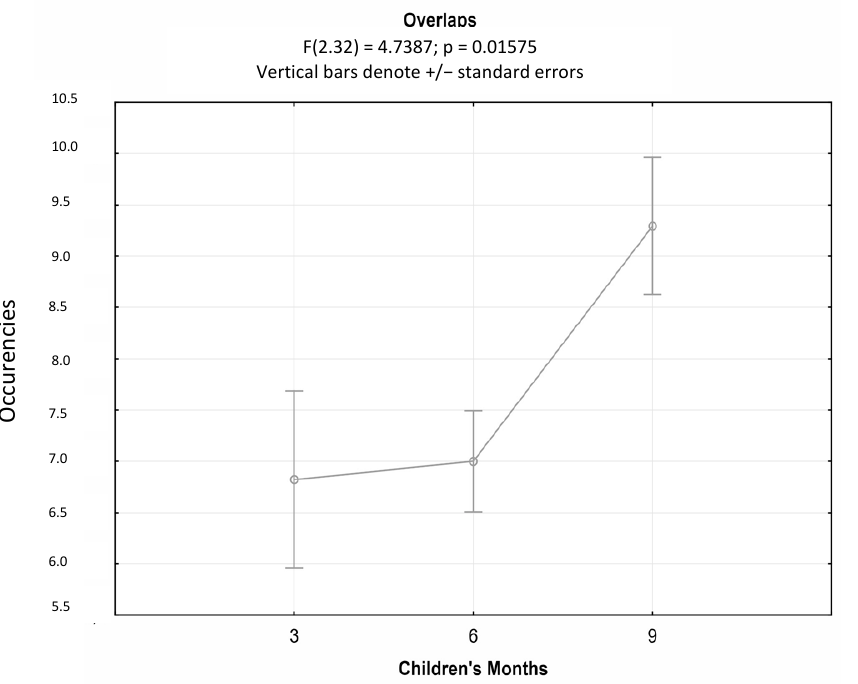
Figure 5. ANOVAs for repeated measures of the average occurrences of overlaps at three, six, and nine months.